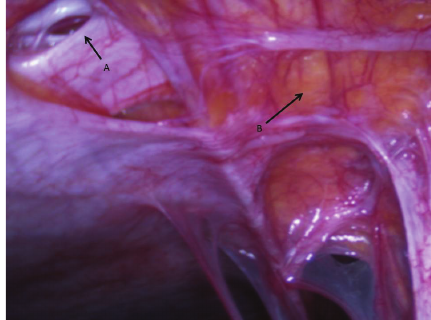
Figure 3: Arrow’s: (A) defect in the fascia, communicating with the umbilical swelling; (B) no peritonealization of the abdominal cavity.